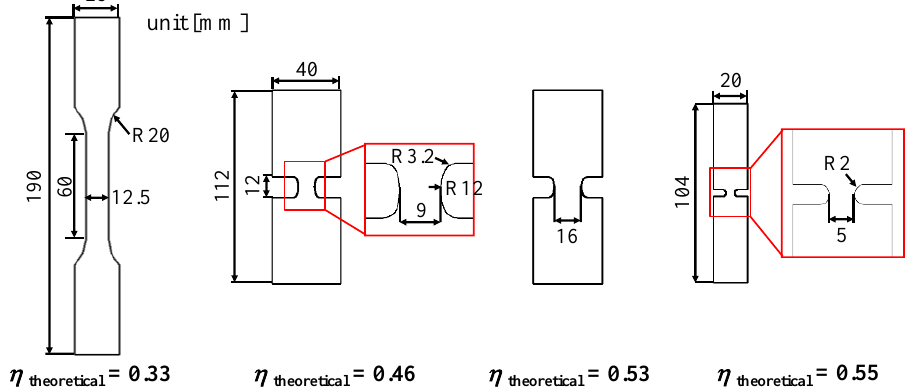
ff erent stress